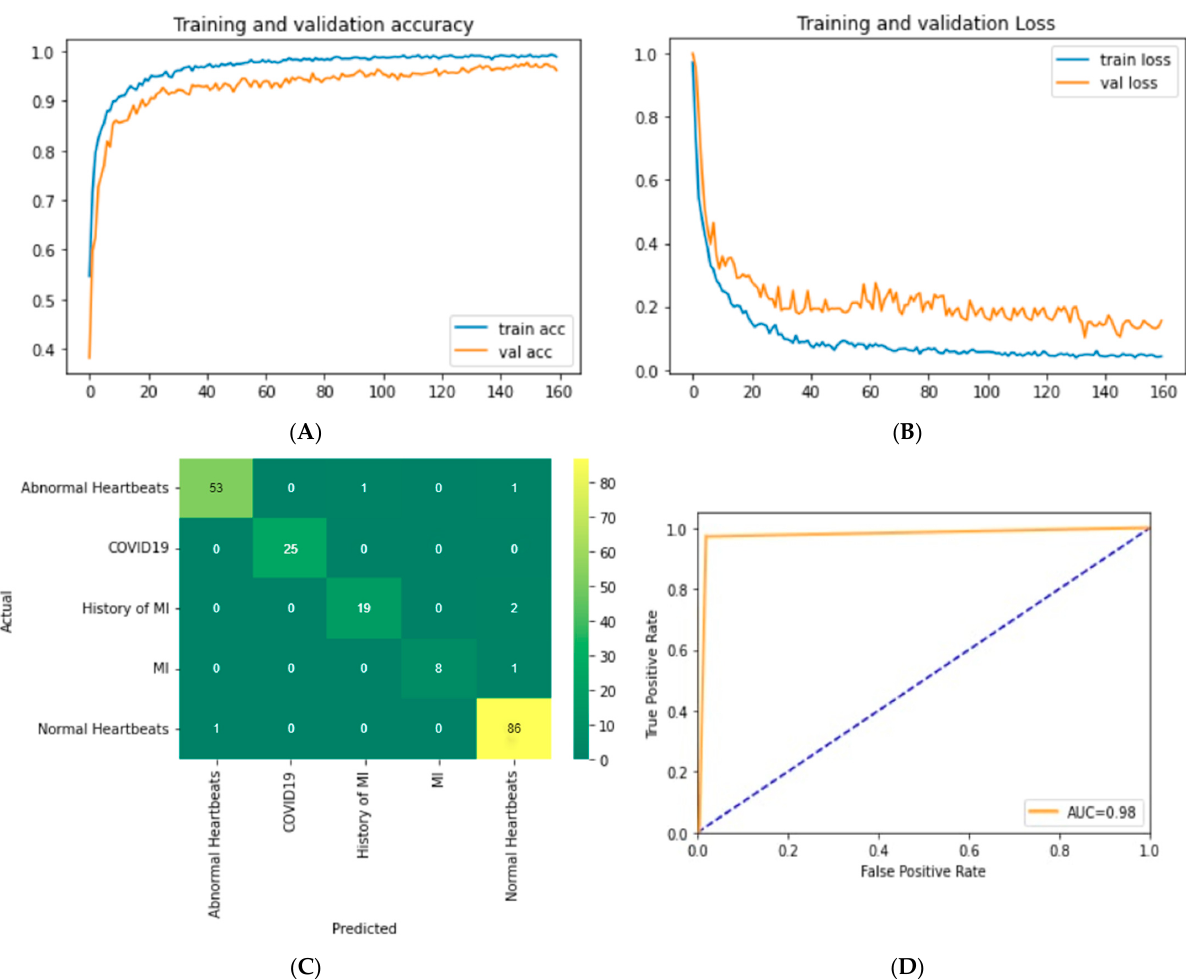
Figure 12. ( A ) Accuracy and ( B ) loss curve for training and validation over 160 epochs for Adam optimizer with a learning rate of 0.0007, ( C ) Confusion matrix ( D ) ROC curve for the optimal result of the proposed InRes-106 model after ablation study. Table 2. Performance result analysis of the deep learning models on the pre-processed